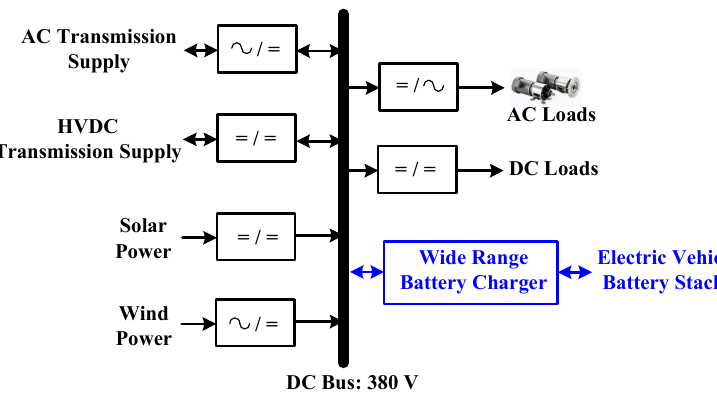
Figure 1. Block diagram of a simplified DC microgrid system.